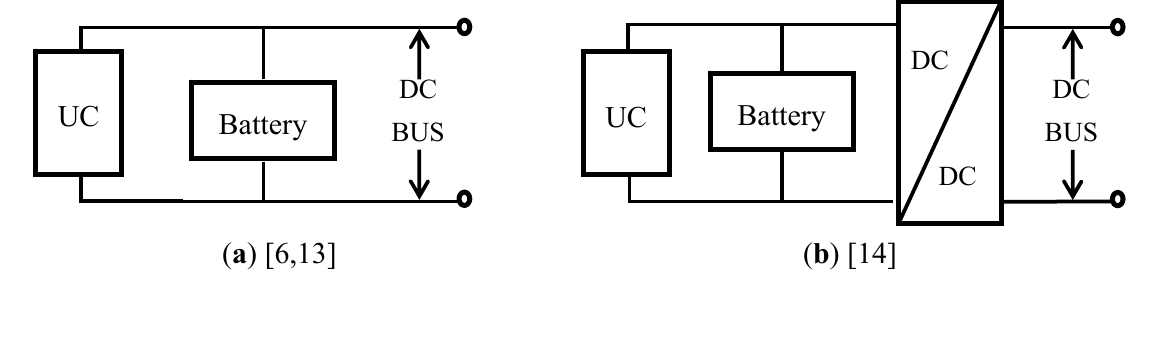
Figure 1. The most common HESS